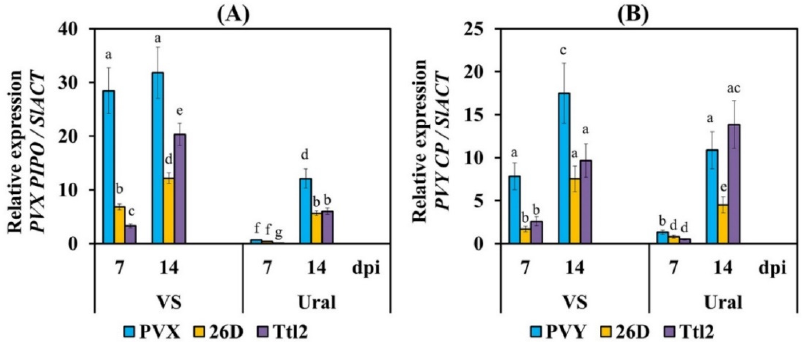
Figure 2. Influence of endophytic strains B. subtilis 26D and B. subtilis Ttl2 on the expression of the viral genes PVX CP ( A ) and PVY PIPO ( B ) in tomato plants of varieties Volovye Serdtse (VS) and Ural at 7 and 14 days post-inoculation (dpi). The expression values were normalized to the housekeeping gene of tomato plants SlACT as an internal reference. The samples are indicated as follows: PVX, plants infected with potato virus X; PVY, plants infected with potato virus Y; 26D, plants treated with B. subtilis 26D; Ttl2, plants treated with B. subtilis Ttl2. The figures present means ± SE (n = 6). The treatments marked with similar Latin letters in one cultivar do not differ significantly, according to the LSD test ( p ≤ 0.05).